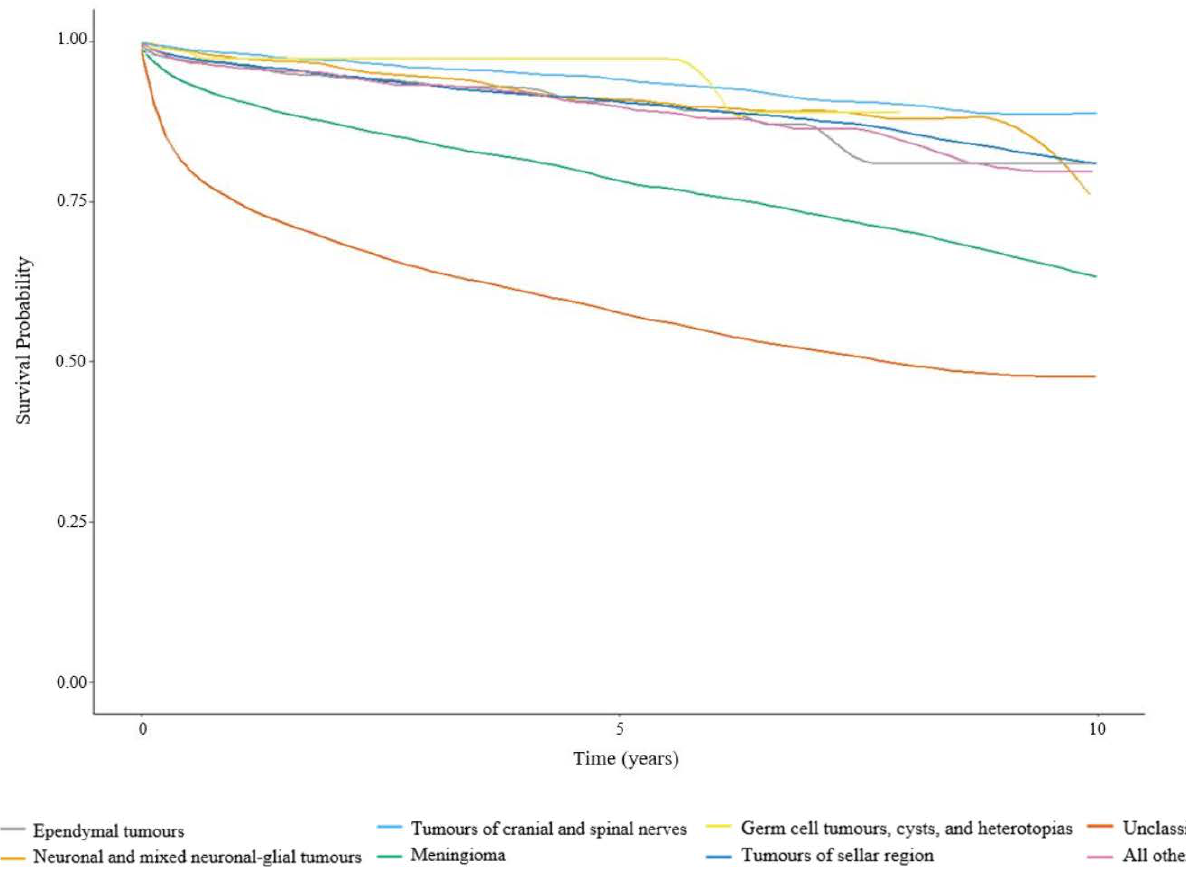
Figure 4. Kaplan–Meier survival curves for primary non-malignant CNS tumour patients diagnosed between 2008 and 2017 in Canada (excluding Quebec), stratified by selected histology. “All other tumours” include the following: unique astrocytoma variants, choroid plexus tumours, mesenchymal tumours, primary melanocytic lesions, other neoplasms related to the meninges.